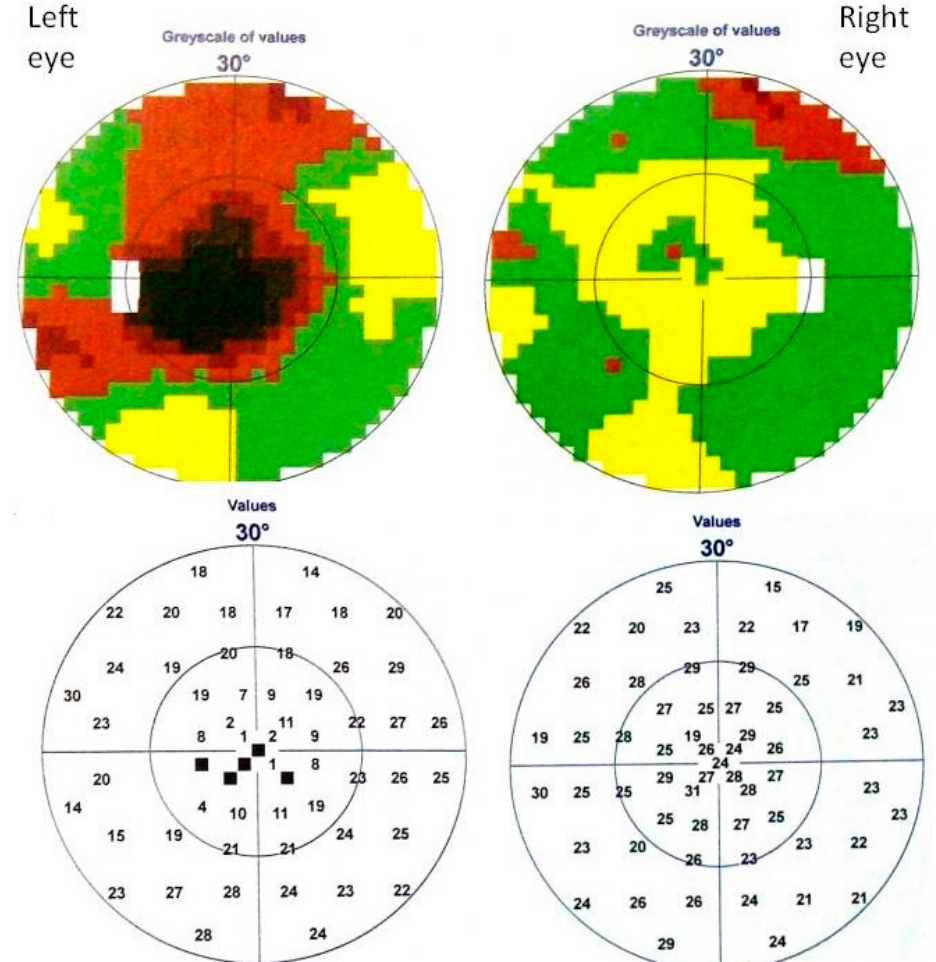
Figure 1. The middle child. First examination (January, the year of diagnosis). Absolute central scotoma was found in the visual field of the LE (Octopus 1-2-3, glaucomatous program tG1). Mean Defect: right eye 5.1, left eye: 12.9.